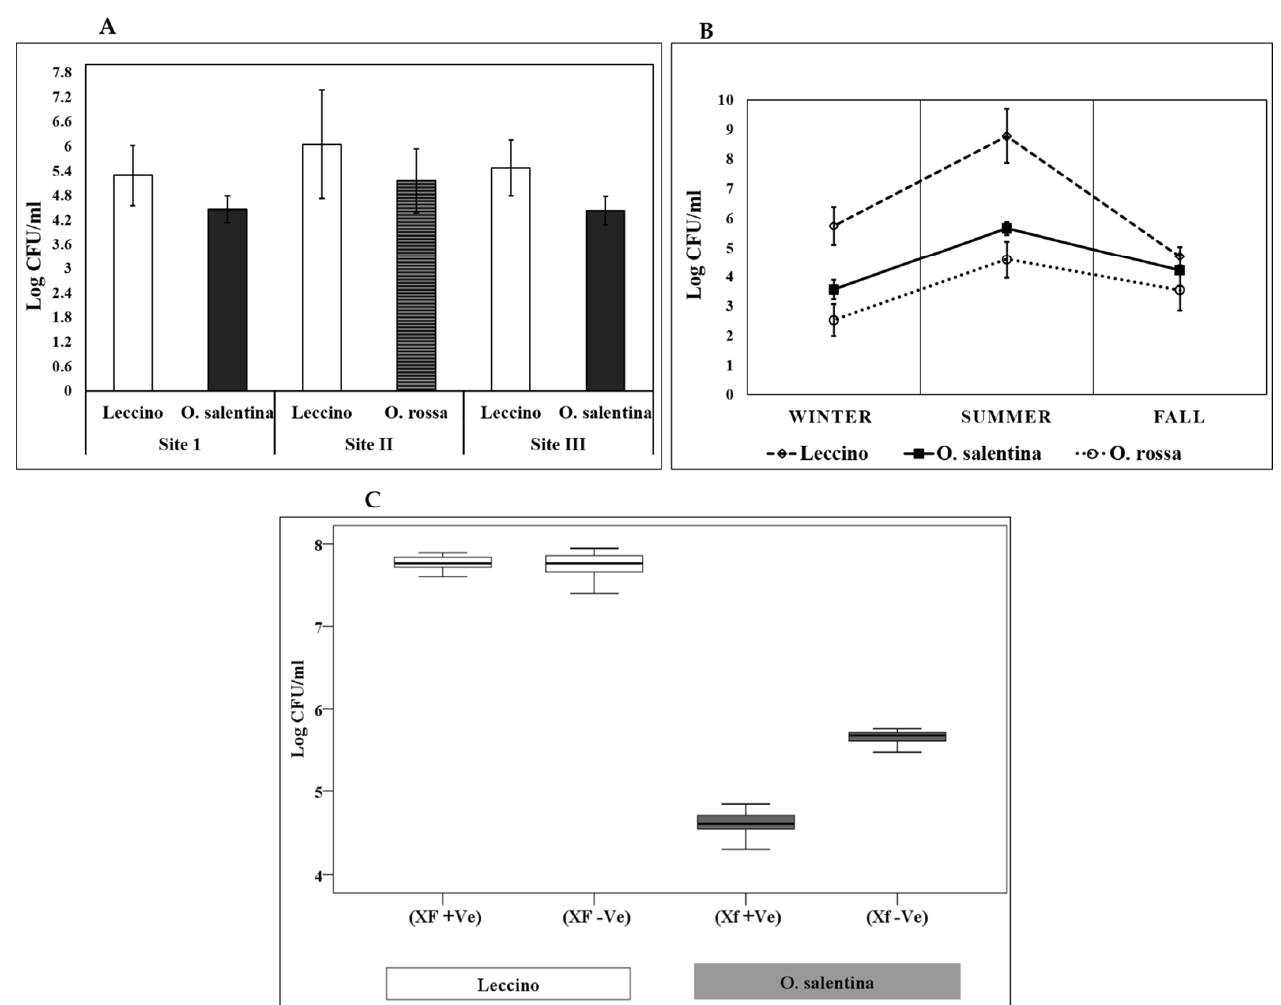
Figure 3. Illustrations of bacterial endophytes occurrence and variation. ( A ) The annual average of CFU/mL obtained from the twig’s sap of different olive varieties within different sampling sites. Data represent mean ± Std. ( B ) Seasonal variation of bacterial occurrence in different olive varieties. The occurrence is based on the number of colonies that appeared on NA and King B media. Bars indicate a significant difference between means by one-way analysis of variance (ANOVA) and the least significant difference (LSD) tests ( p < 0.05). ( C ) Boxplot diagram showing a variation of the bacterial community occurrence between infected and non-infected olive varieties in the sampling site III.